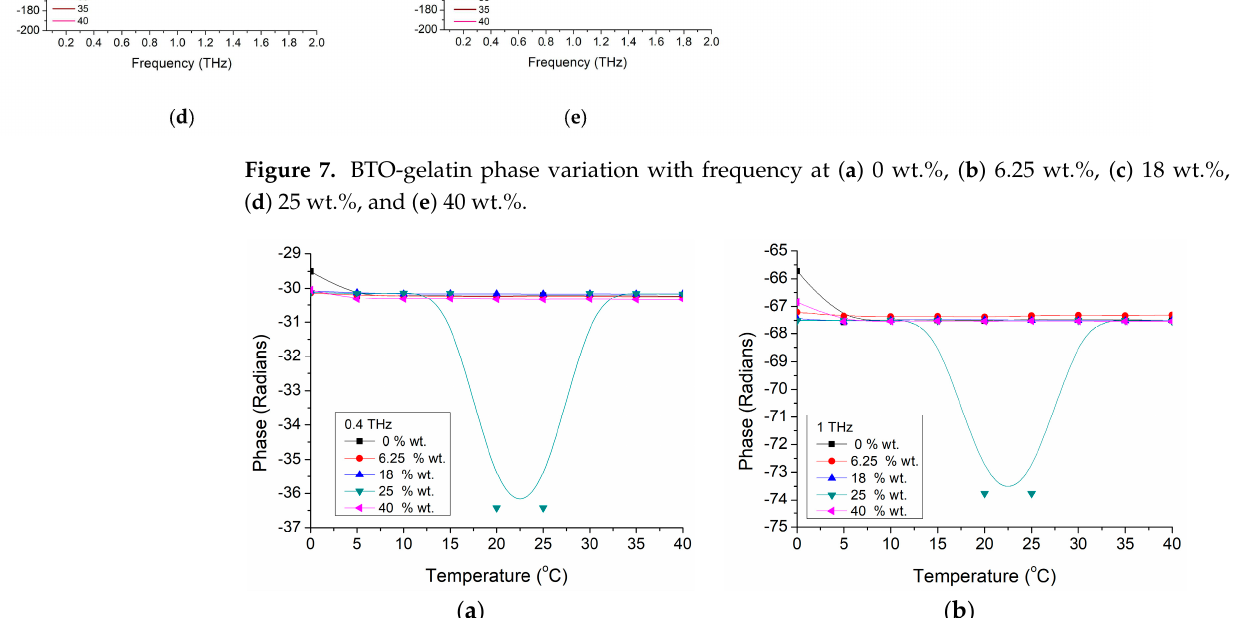
Figure 7. BTO-gelatin phase variation with frequency at ( a ) 0% wt, ( b ) 6.25% wt, ( c ) 18% wt, ( d ) 25% wt, and ( e ) 40% wt.